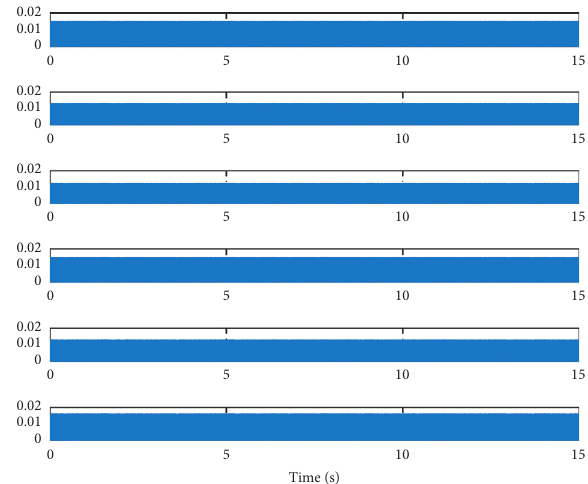
Figure 7: Measurement noises for joint positions q